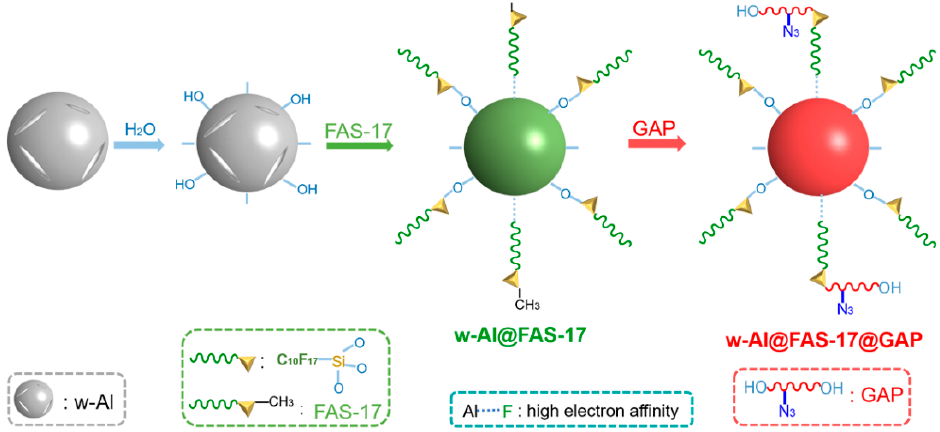
Figure 1. The schematic diagram of the preparation process of w-Al@FAS-17 and w-Al@FAS-